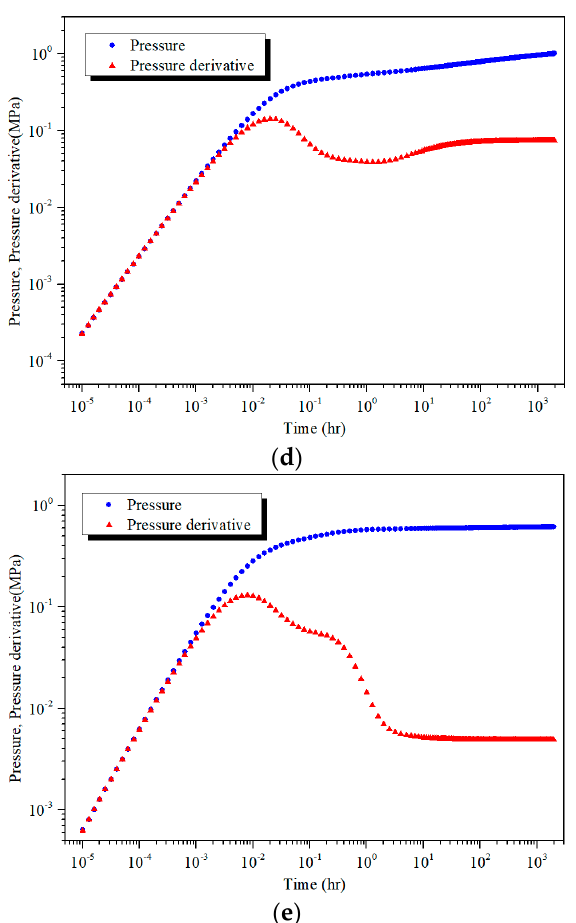
Figure 4. The typical well test curves for models used in this work. ( a ) Infinite-conductivity vertically fractured model without skin factor (Model 1); ( b ) infinite-conductivity vertically fractured model with skin factor (Model 2); ( c ) dual-porosity model with pseudo-steady state (Model 3); ( d ) radial composite model with mobility ratio >1 and dispersion ratio >1 (Model 4); ( e ) radial composite model with mobility ratio <1 and dispersion ratio >1 (Model 5).